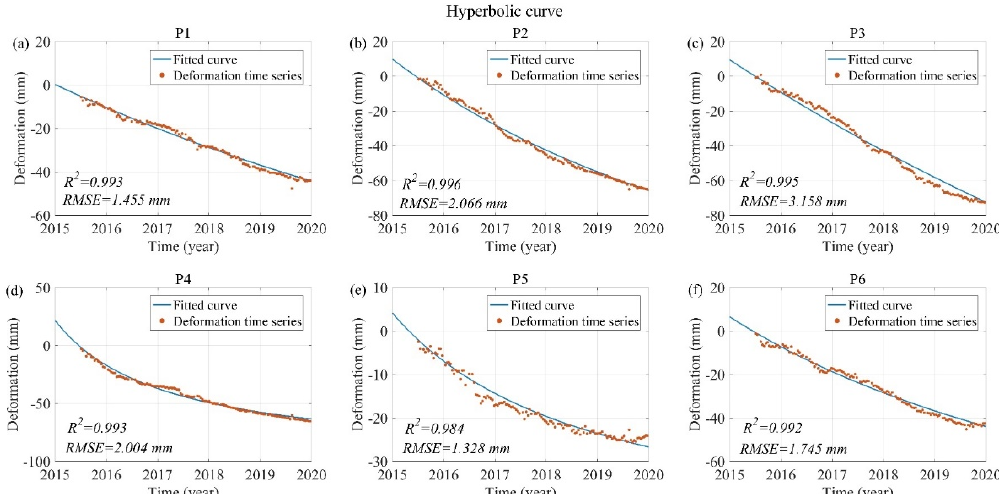
Figure 5. Hyperbolic curve fitting of ( a ) P1, ( b ) P2, ( c ) P3, ( d ) P4, ( e ) P5 and ( f ) P6. Locations of points P1−P6 are shown in Figure A1.